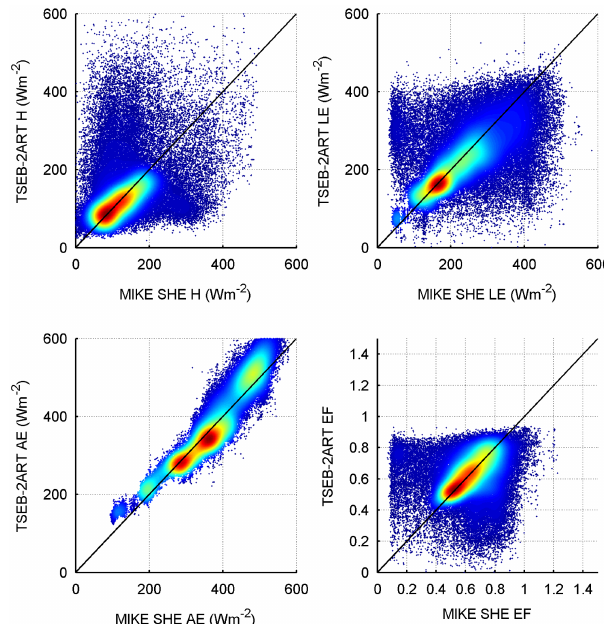
Figure 3. Density scatter plot of over 95000 points comparing the sensible heat flux (top left), latent heat flux (top right), available energy (bottom left) and evaporative fraction (bottom right) mod- elled by MIKE SHE and TSEB-2ART. Red colour indicates higher density of points, blue colour lower density.